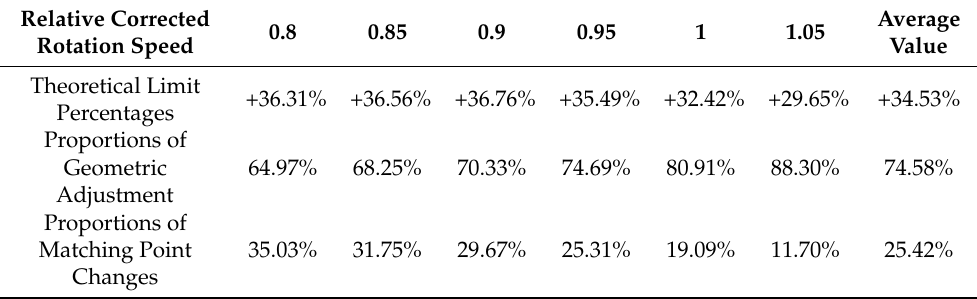
Table 6. The Theoretical Limit Percentages of Flow Rate Adjustment of AFS with Inlet Guide Vane Adjustment.